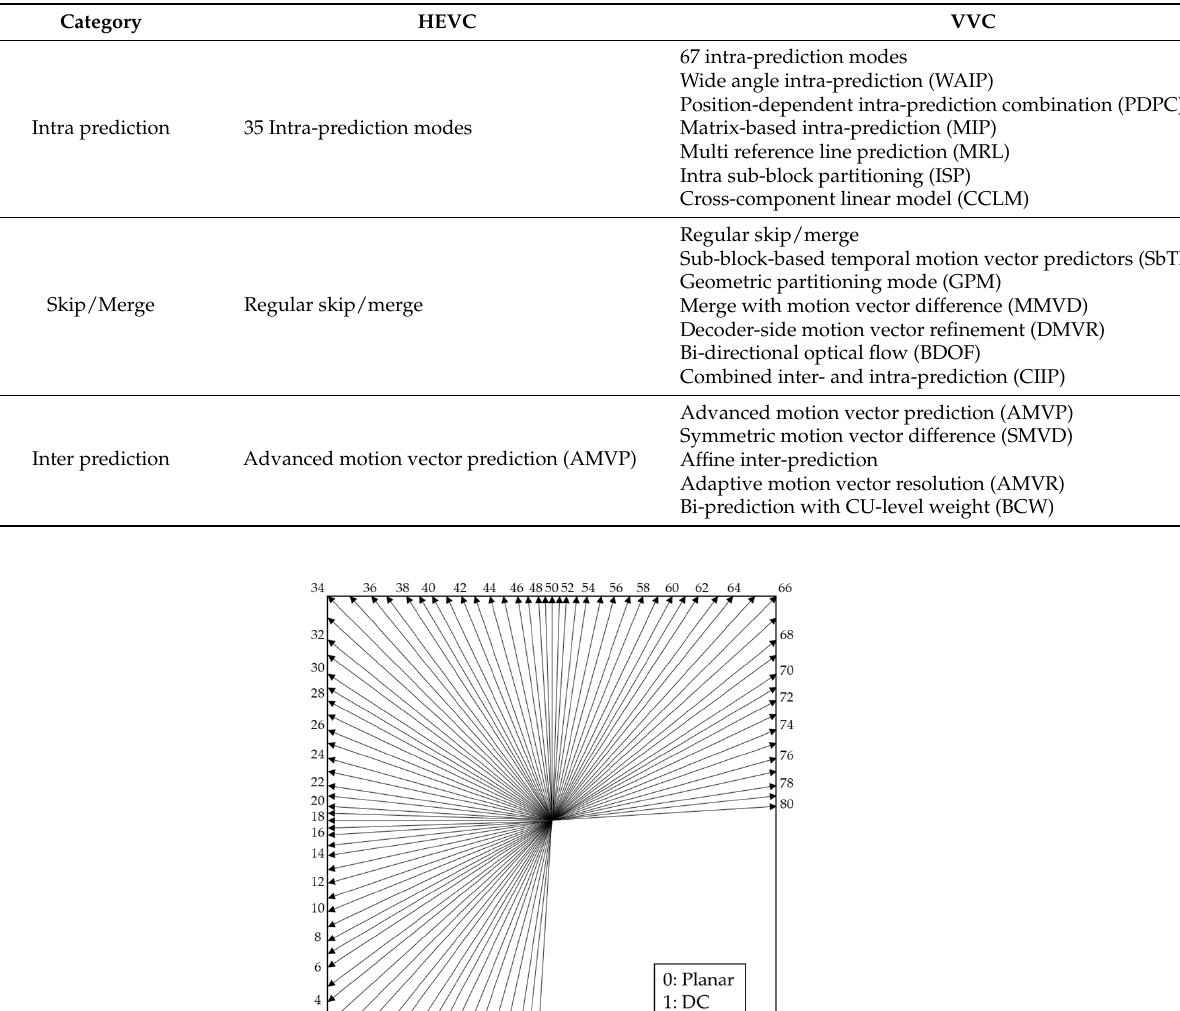
Table 1. The list of video coding tools. Comparison between HEVC and VVC.